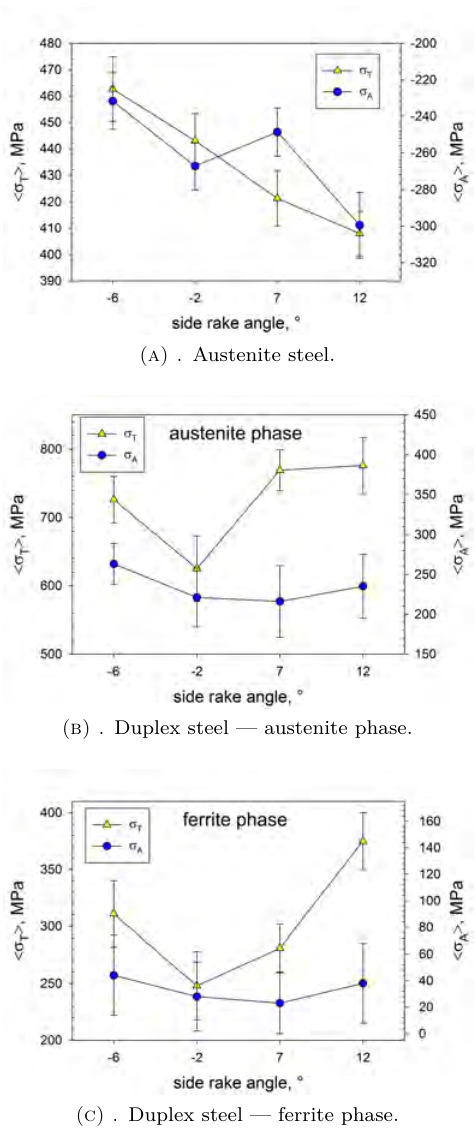
Figure 2. Axial and tangential residual stresses h σ A i , h σ T i , MPa on the side rake angle, ◦ .